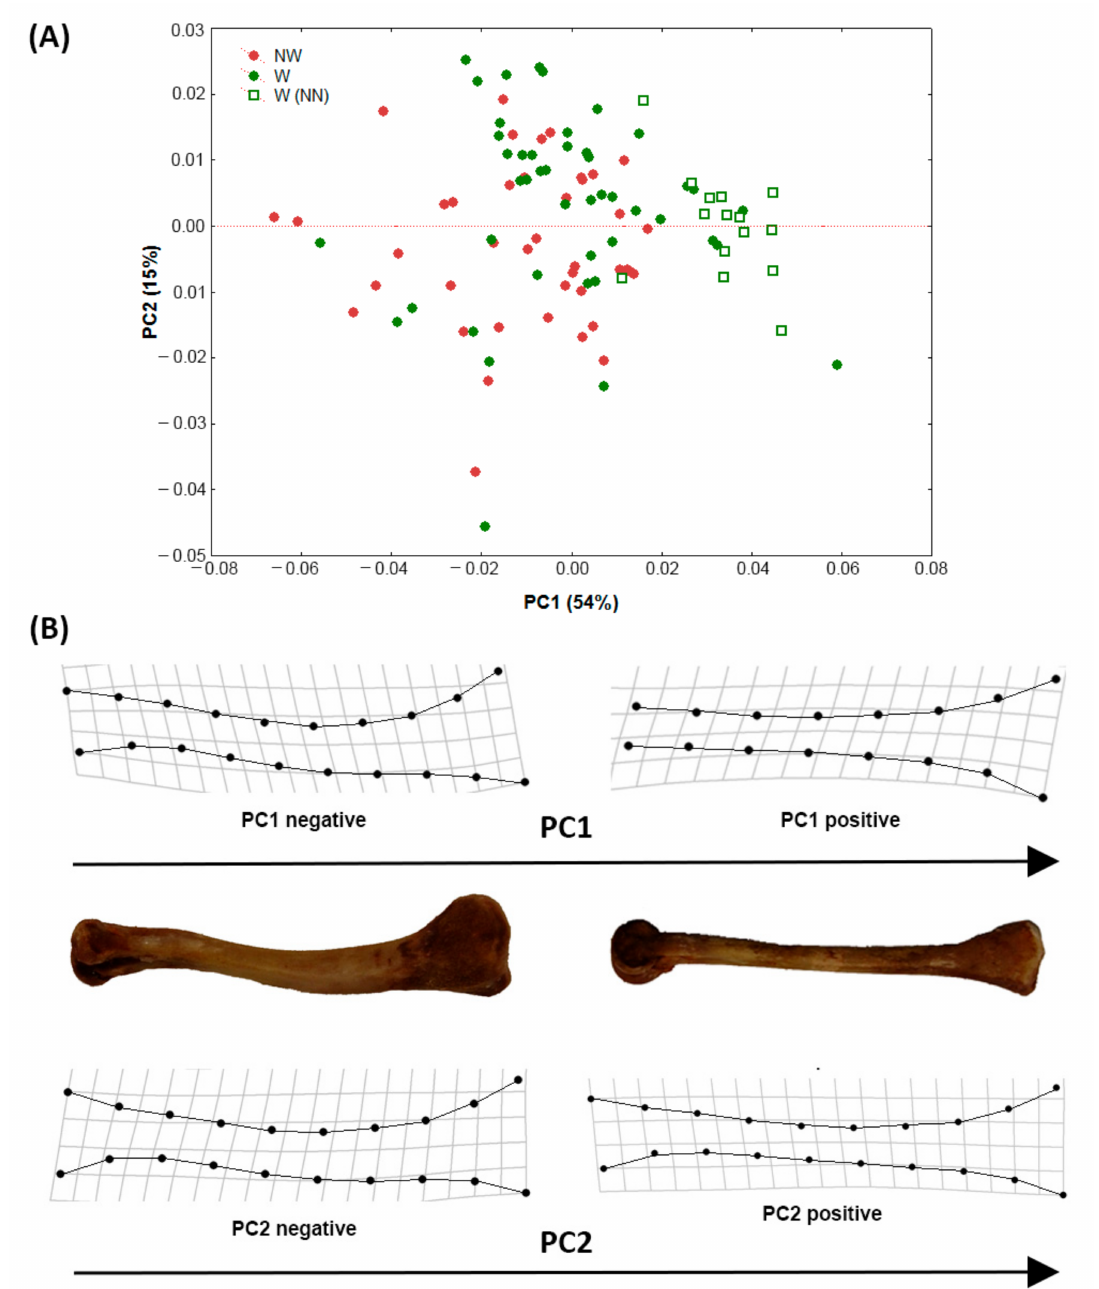
Figure 2. ( A ) Principal component analysis plot. Grouping variable: Walking (W)/not-walking (NW)/walking naked neck (W-NN). ( B ) Shape variation along PC1 and PC2 was represented by splines relative to positive and negative extremes of the axes. For shape variation along PC1, tibiae of two extreme individuals were